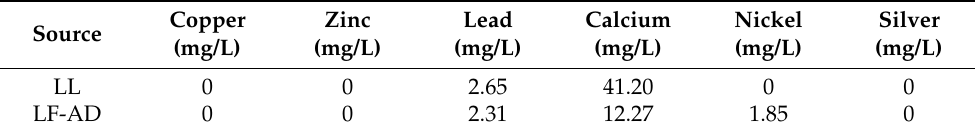
Figure 6. NRE, NLR, and NRR in L-1 and L-2 of the LLTP after the UF process. Table 5. Heavy metals and calcium concentrations in landfill leachate and